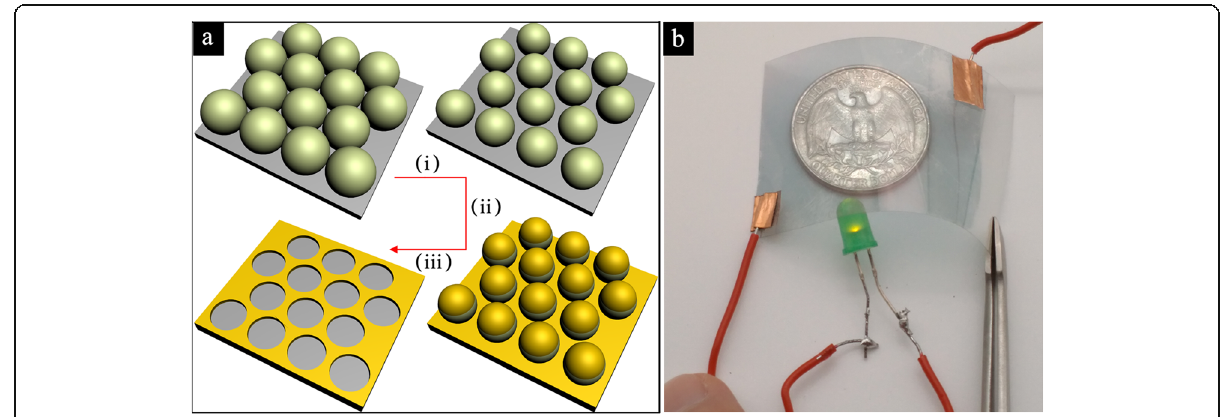
Fig. 1 a The preparation flow schematic of AuNM electrode. b The demonstration of transmittance and conductivity